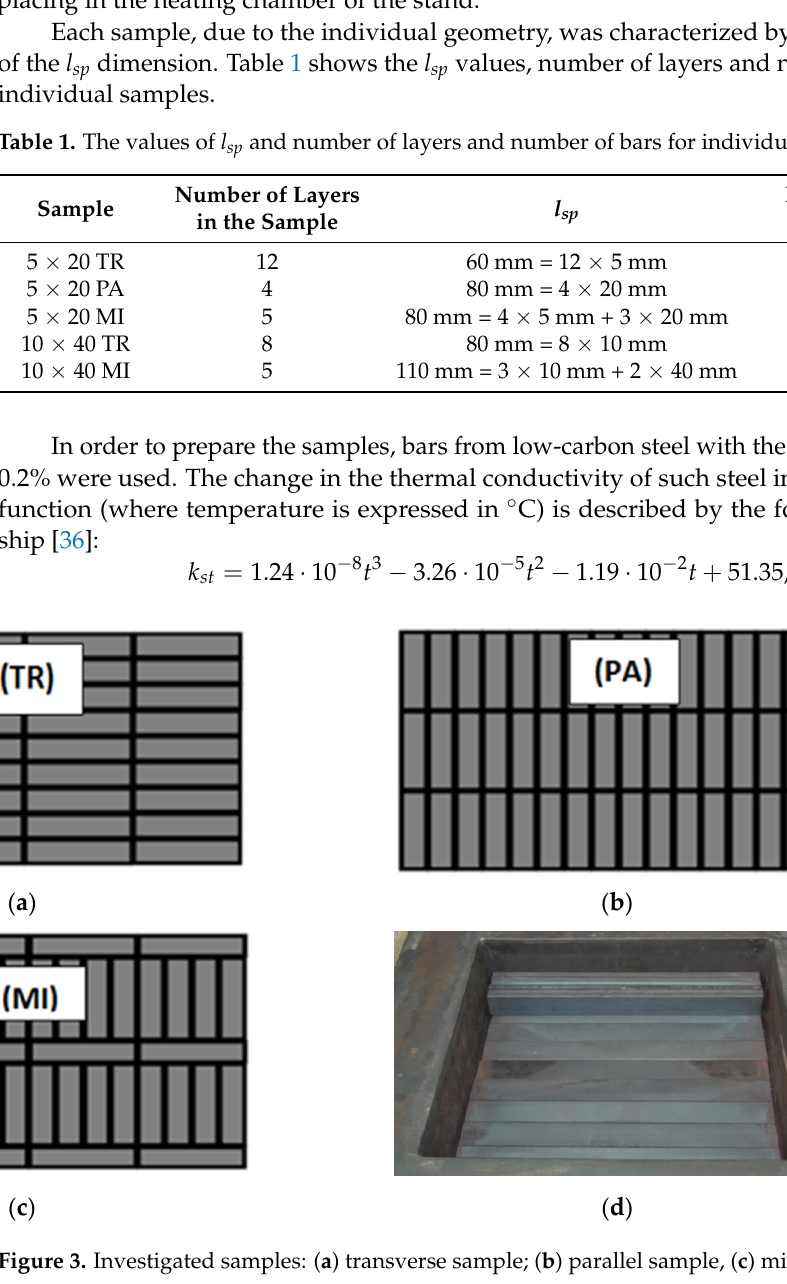
( b ) Figure 4. Measured effective thermal conductivity as a function of temperature: ( a ) results obtained for samples made of 5 × 20 mm bars; ( b ) results obtained for samples made of 10 × 40 mm bars. As shown, the value of k ef coefficient depends on the bar dimensions and their ar- rangement. The lower the compaction of the layers of the bars on a unitary length, the bigger this parameter becomes. This results from the fact that the thermal resistance of the joints of the adjacent layers of bars is much bigger than the heat conduction resistance in the bars themselves. In general, the coefficient k ef assumes the values in the range from 1.96 to 5.32 W/(m·K) and increases linearly in the temperature function. For this reason, the measurement results have been approximated with linear regression functions: ( )